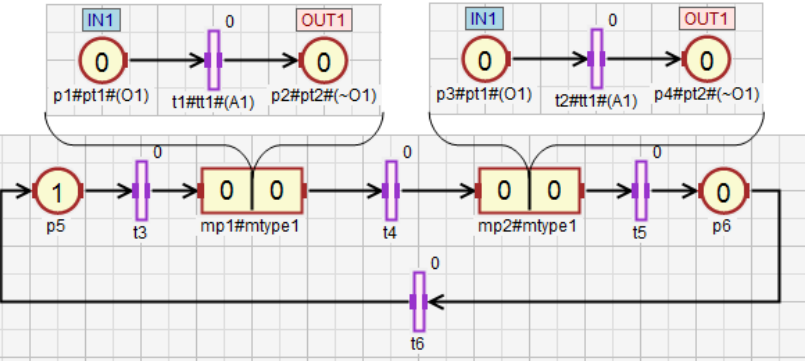
Figure 5. The net with two macroplaces of the same type and shared input and output